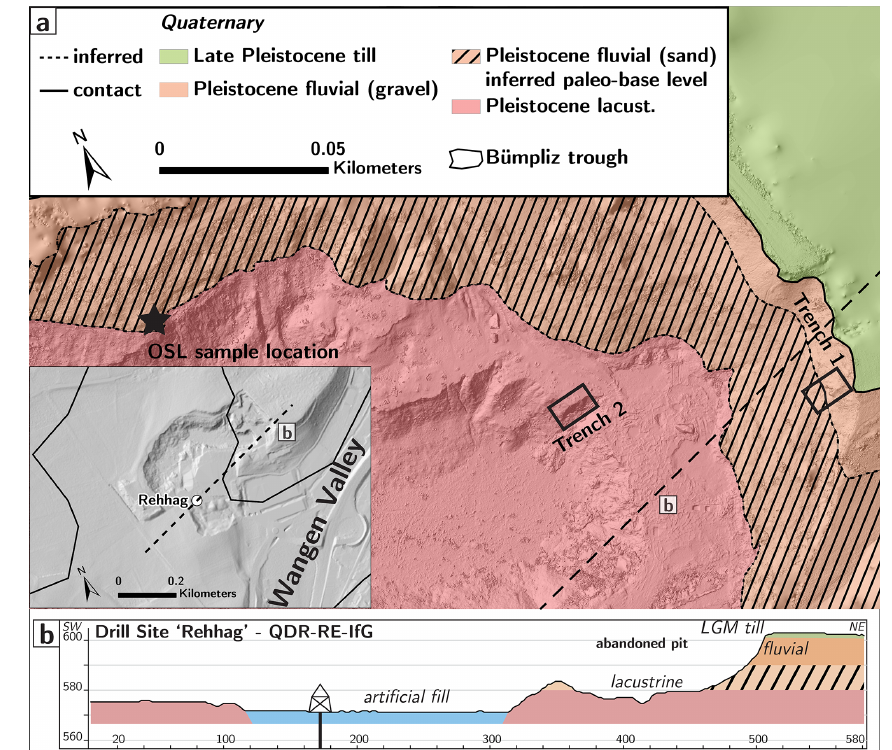
Figure 3. (a) Detailed overview of the abandoned Rehhag clay pit with the OSL sample location and two trenches. At these three positions, the composition, texture, and fabric of the sediment were analyzed in more detail, as these are the sites that record the transition from a lacustrine to a fluvial environment. The displayed geological map resulted from our mapping in the clay pit. More detailed information is available in Sect. 4. The outcrop sequence overlaps with the sedimentary sequence recovered in the drilling at an elevation of 567m.a.s.l. or 4m core depth. The map inlet shows the entire Rehhag clay pit and the location of the drill site. Furthermore, the position of the cross section in (b) is indicated, along with the outline of the overdeepening and part of the adjacent Wangen Valley. (b) SW–NE-oriented cross section through the study site, showing the geological details at the Rehhag (2 × exaggerated). The lacustrine sediments correspond to the top of sequence B, whereas the fluvial gravel beds correspond to sequence C in this paper (Forstschotter; Sect. 8.2). In the section, the LGM till is only a few meters thick. Note the 23 ◦ shift relative to the north. The elevation data in the main map were produced from a drone survey. Elevation data in the inlet map with 2m resolution from ©